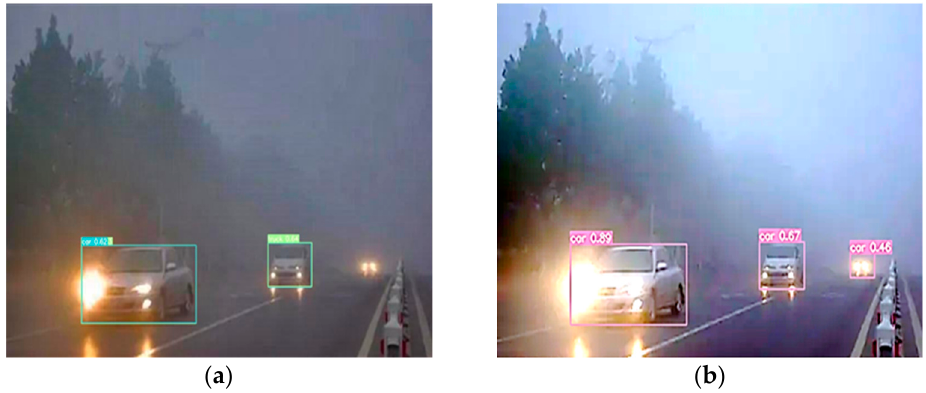
Figure 1. Object Detection in Low-Light Foggy Traffic Environments. ( a ) Image visualization and detection accuracy are low for object detection using only YOLOV7, YOLOV7; ( b ) The method proposed in this paper not only improves the detection accuracy but also reduces the leakage rate, IDOD-YOLOV7 (Ours).